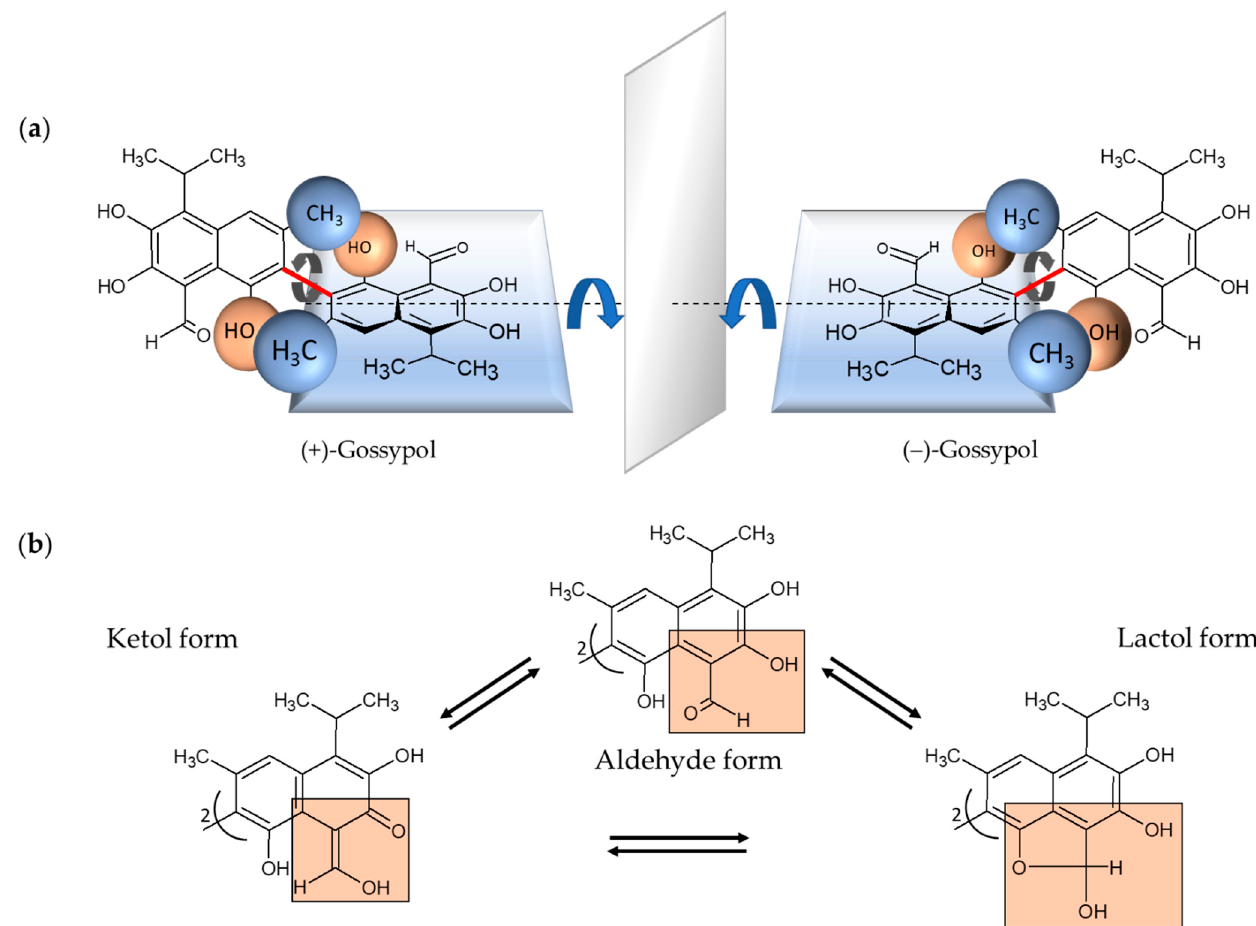
Figure 1. Chemical structural formulas of the enantiomers of gossypol and their tautomeric forms. ( a ) (+)- and ( − )-enantiomers of gossypol behave structurally like an image and a mirror image. The rotation around the binaphtyl bond (marked red) is restricted because of the sterically hindering methyl- and hydroxyl-groups of the two naphthalene units (indicated as blue and brown balls for the corresponding methyl- and hydroxyl-groups, respectively). In this special case of axial chirality, the so-called atropisomerism, the formed enantiomers, also known as rotamers, are largely stable. ( b ) Depicted are the tautomeric forms of gossypol, aldehyde, ketol and lactol form, which can be converted into each other. In each case, one of two identical naphthyl residues is shown with the relevant substituents marked in orange boxes.